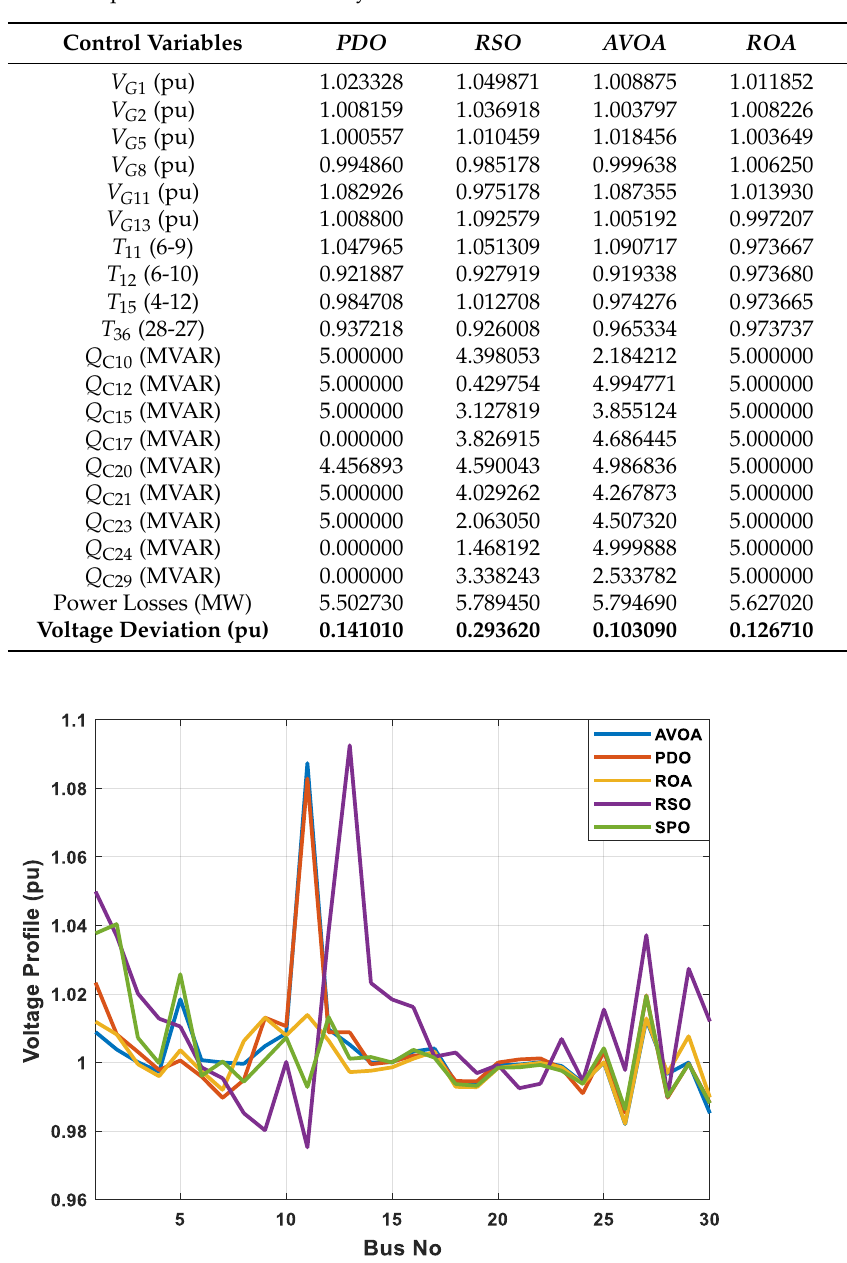
Figure 4. The AVOA convergence characteristics with the other compared methods for case 1. According to Table 7, all proposed algorithms succeeded in minimizing the VD objective function considering operational constraints and achieving real and reactive power balance. Also, the performance evaluation of the proposed algorithms based on VD and the “ number of runs is 5 0” with statistical analysis is illustrated in Table 8. The AVOA algorithm ’ s narrow range between minimum and maximum values presents a minimum stander deviation value (0.02875 pu). Additionally, it achieves a suitable mean value of computational time (18.85260 s) among other compared algorithms. Table 7. Balance of active and reactive power for proposed algorithms with case 1. Method